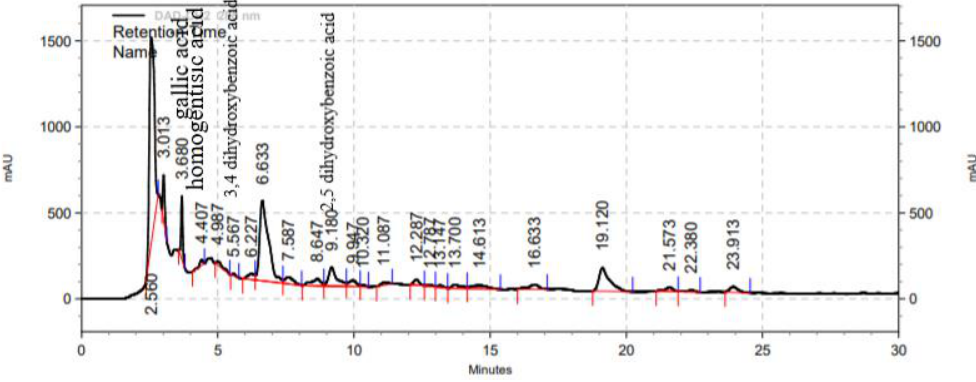
Appl. Sci. 2020 , 10 , x FOR PEER REVIEW Figure 2. HPLC chromatograms of STOMAPET at 280 nm—hydroxybenzoic derivatives. Figure 2. HPLC chromatograms of STOMAPET at 280 nm—hydroxybenzoic derivatives. Figure 2. HPLC chromatograms of STOMAPET at 280 nm—hydroxybenzoic derivatives.